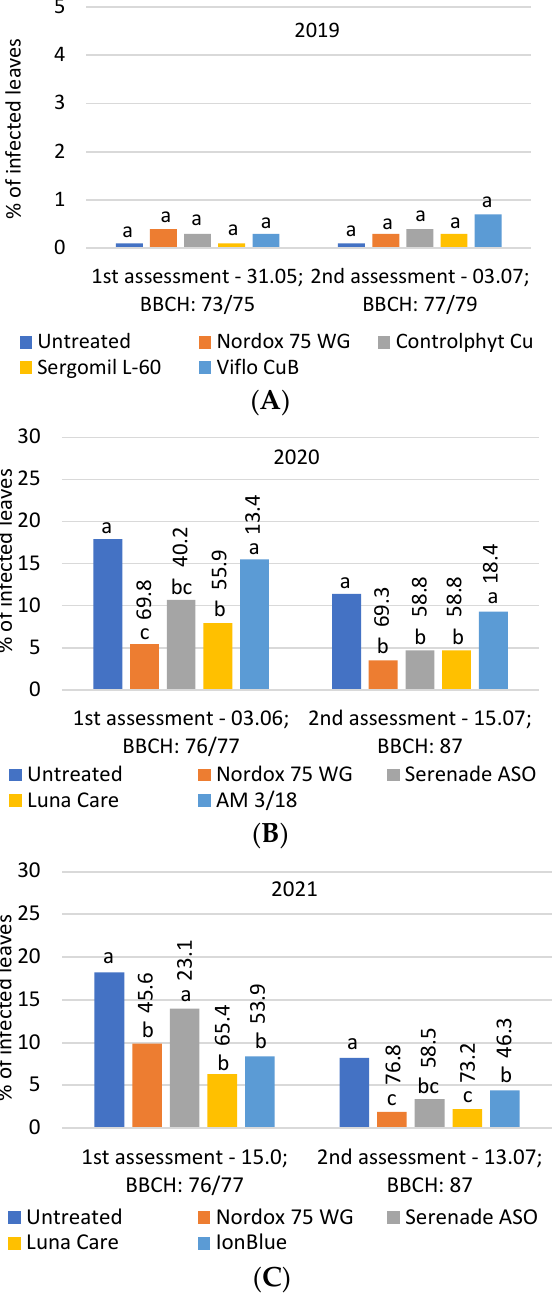
Figure 4. ( A – C ) Incidence of infection by bacterial canker (caused by P. syringae ) on leaves of sweet cherry after foliar applications of different products during the flowering period in 2019–2021. Efficacy values are shown above each bar. The means marked by the same letter do not differ according to the Newman-Keuls test at the 5% significance level.